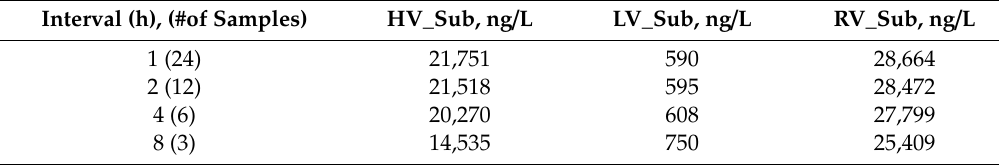
Table 5. Average concentrations of the three substances in the case of time proportional sampling (with the di ff erent number of samples collected).